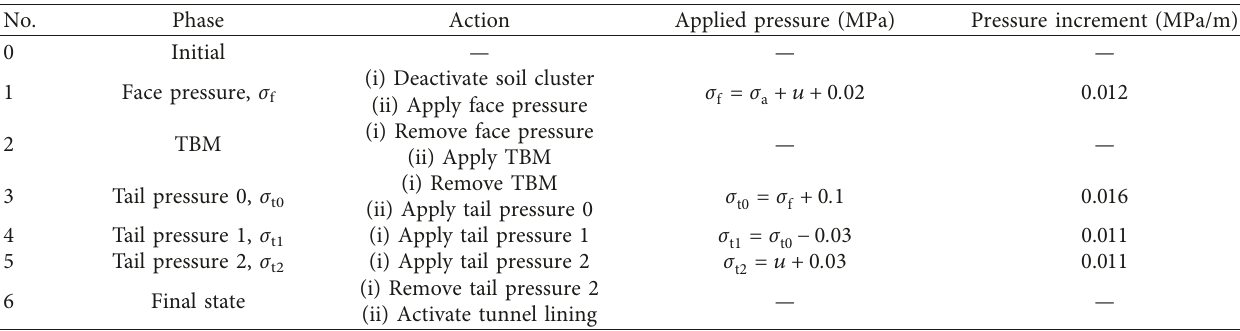
Figure 3: (a, b) Comparison of settlements obtained from constitutive models (Diaz and Bezuijen [25]) and field measurement (M¨oller and Vermeer [26]). Table 1: PLAXIS 2 D construction phases (Schotte et al. [24]).